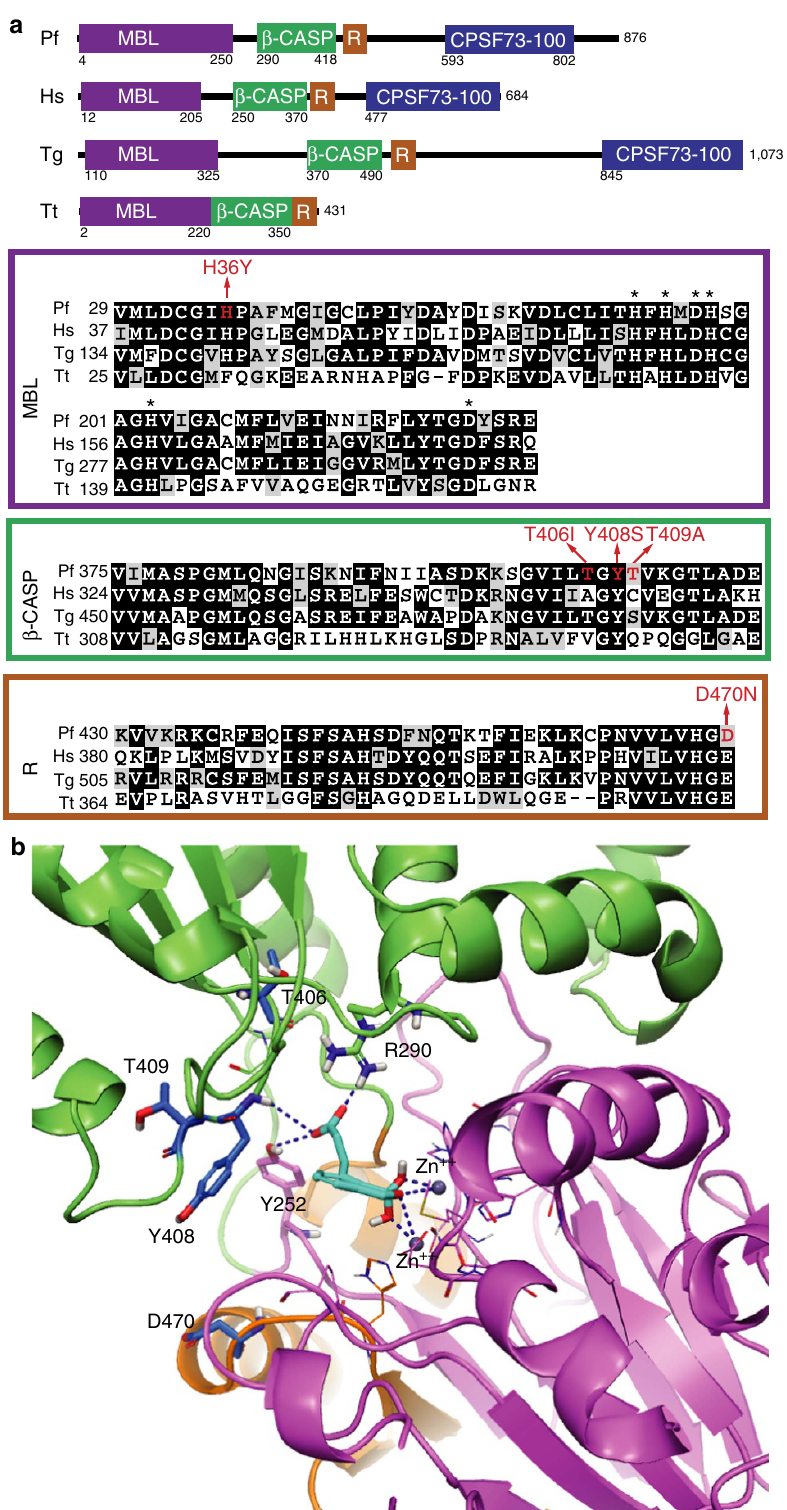
Figure 6 | AN3661 resistance mutations reside in the MBL and b -CASP domains of PfCSPF3. ( a ) Conserved domains predicted by NCBI for PfCPSF3 and its homologues in humans (Hs, gi:18044212), Toxoplasma gondii (Tg, KFG54681.1) and T. thermophilus (Tt, TTHA0252). R, RNA-metabolizing MBL domain. Amino acid numbers are shown for each protein. Asterisks denote amino acids predicted to bind the two zinc atoms in the MBL domain. Amino acids in red were mutated after drug selection. ( b ) Model of AN3661 (cyan) at the active site of PfCPSF3 (MBL domain, mauve; b -CASP domain, green, RNA-metabolizing MBL domain, orange), built based on the crystal structure of T. thermophilus TTHA0252 (PDB code: 3IEM). Residues D470, Y408, T409 and T406, which were mutated after selection by AN3661, are shown as blue stick models. The negatively charged benzoxaborole group interacts extensively with the two catalytic zinc ions (grey), and the carboxylate side chain interacts with R290 and Y252, forming a salt bridge and hydrogen bond,